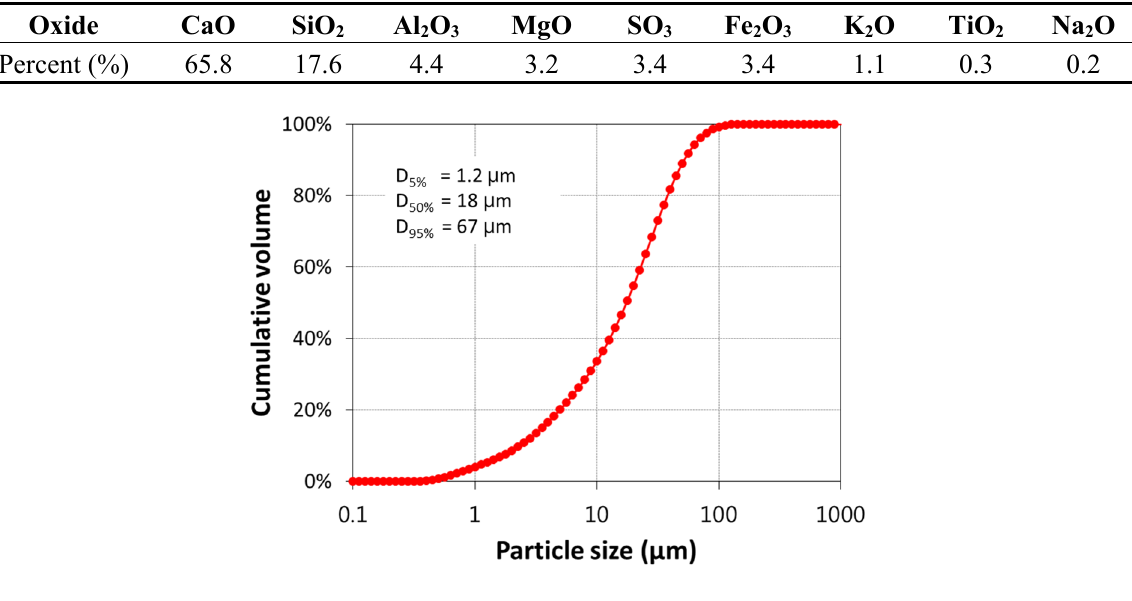
Table 1. Oxide composition of cement.